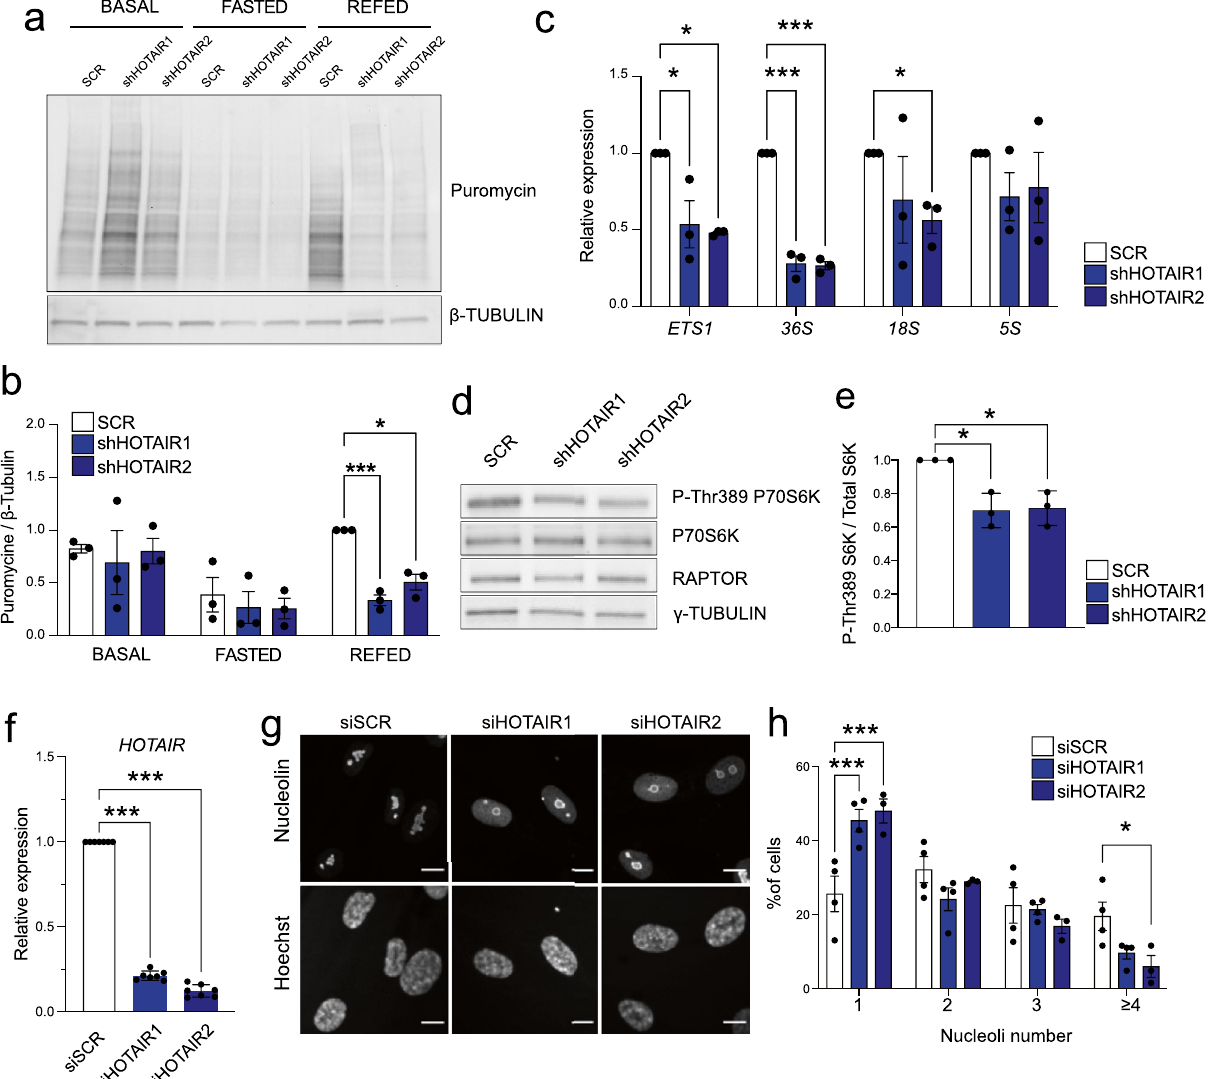
Figure 2. HOTAIR KD impairs refeeding-induced protein synthesis in proliferating G-ASCs. ( a ) SUnSET analysis of protein synthesis rates in basal, 24-h fasting (HBSS, 0.2% FFA-free BSA) and 24-h refeeding conditions in SCR, shHOTAIR1 and shHOTAIR2 G-ASCs (see Fig. S5 for original blots). ( b ) SUnSET quantification (* p < 0.05, *** p < 0.001, two-way ANOVA with Dunnett’s multiple comparisons test;; n = 3). ( c ) RT-qPCR analysis of pre-rRNA (ETS1, 36S), 18S and 5S rRNA after 24-h refeeding (* p < 0.05, *** p < 0.001, two-way ANOVA with Dunnett’s multiple comparisons test;; n = 3). ( d ) Western blot analysis of phospho- Thr389 P70S6K, total P70S6K, RAPTOR and γ-Tubulin protein levels after 24-h refeeding (see Fig. S6for original blots). ( e ) Quantification of phospho-Thr389 P70S6K/total P70S6K and RAPTOR/γ-Tubulin (* p < 0.05, two-tailed paired T test, n = 3). ( f ) RT-qPCR validation of transient HOTAIR KD in proliferating G-ASC (mean ± SD; *** p < 0.001, ANOVA with Holm-Sidak’s multiple comparisons test; n = 7). ( g ) Immunostaining of Nucleolin in siSCR- and siHOTAIR1- and 2-transfected G-ASCs. Nuclei are stained with Hoechst. Scale bar: 10 µm. ( h ) Number of nucleoli per cell quantified from Nucleolin immunostaining in siSCR- and siHOTAIR1- and 2-transfected G-ASCs (mean ± SD; * p < 0.05, *** p < 0.001, two-way ANOVA with Dunnett’s multiple comparisons test; n = 4 independent transfections; > 20 cells measured per